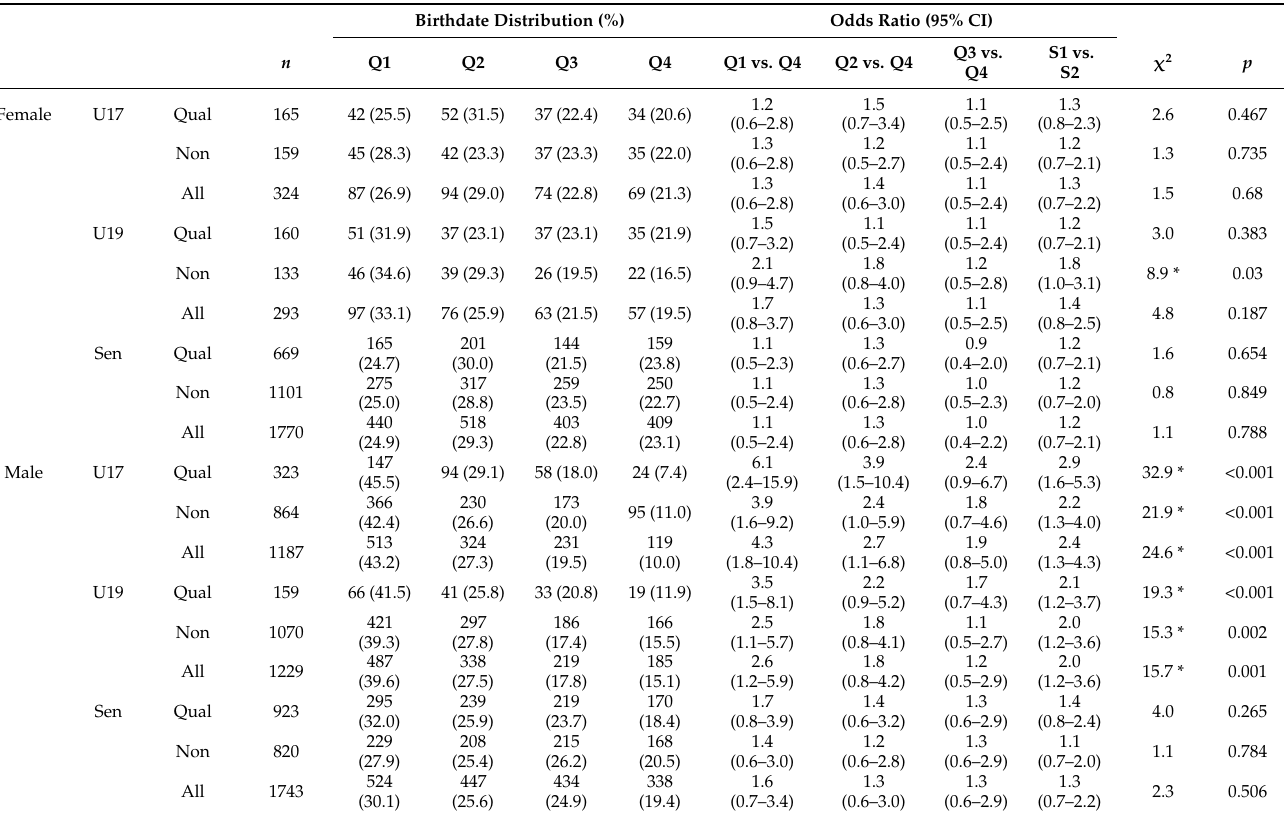
Table 2. Birth quartile distribution by sex, age group, and qualification status (* Significant at an alpha level of p <